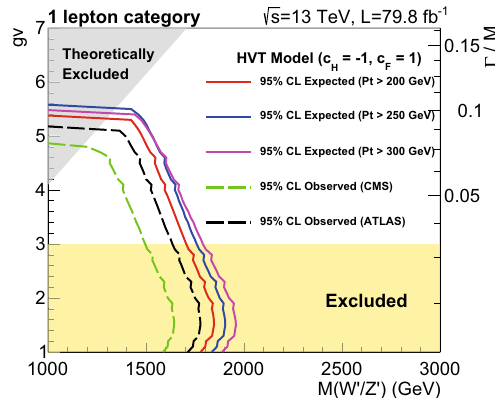
Fig. 14 Expected 95% CL HVT limits as a function of the reso- nance mass and width, for an integrated luminosity of 79 . 8 fb − 1 . The limits for the 1-lepton category are shown for increasing p ⊥ > 200 , 250 , 300 GeV selections. Estimated observed limits by ATLAS and CMS are also shown. The theoretically excluded regions corre- spond to regions of small physical mass and large g V coupling, where the HVT model cannot reproduce the SM input parameters α EW , G F and M